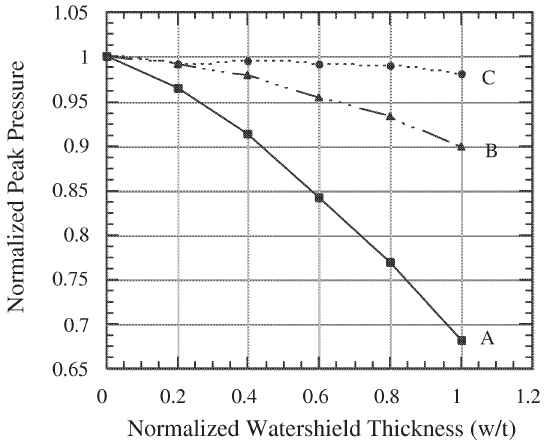
Fig. 6. Calculated peak pressures of contact watershield normalized by the peak pressure of no watershield.